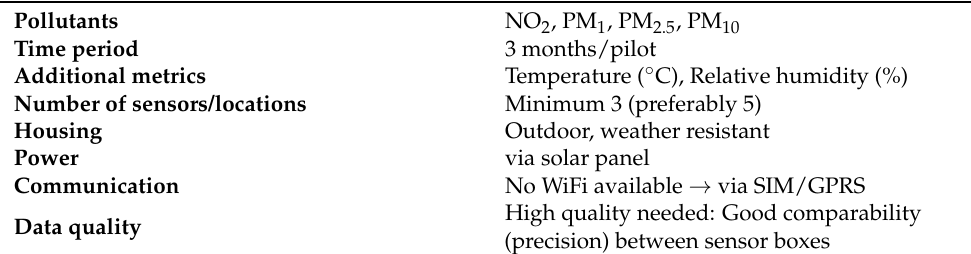
Table 1. Functional requirements of the air quality sensor network.